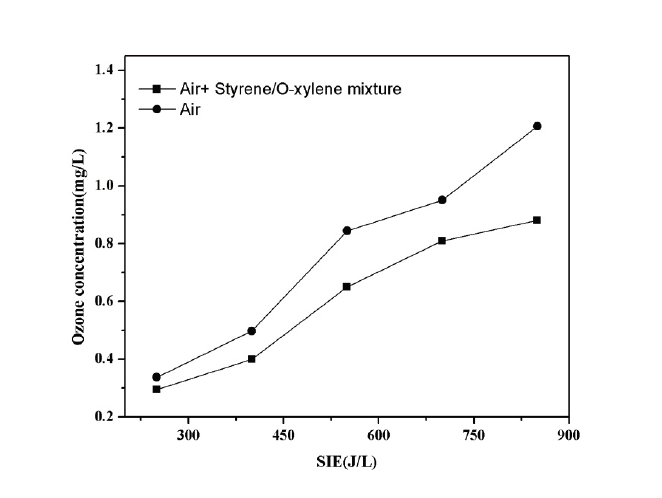
Figure 9. O 3 concentration as a function of the specific input